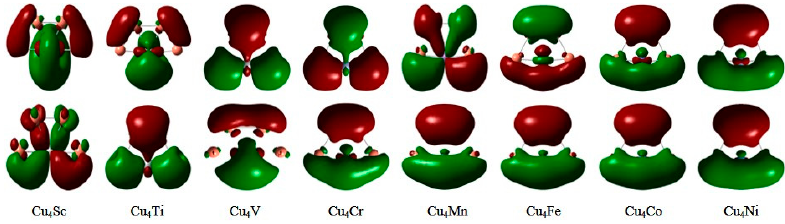
Figure 6. The LUMO ( first row ) and HOMO ( second row ) molecular orbitals of the ground state Cu 4 M (M = Sc-Ni) clusters.